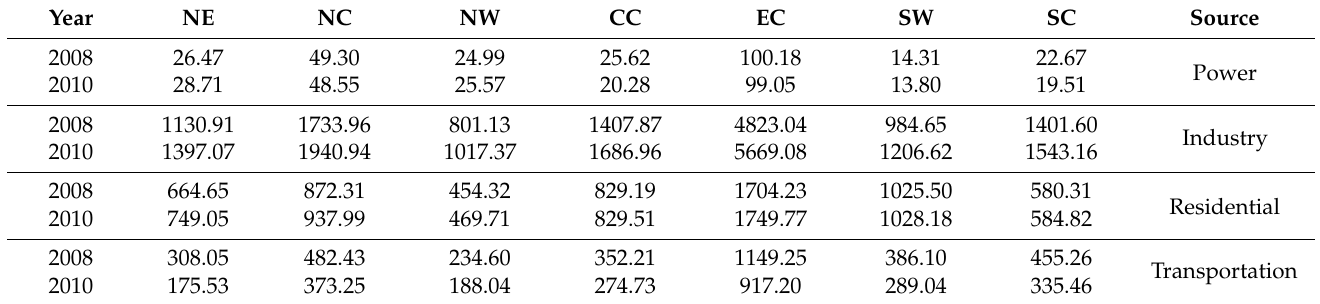
Table 2. VOC emissions from different sources over China in 2008 and 2010 (t · km − 2 · month − 1